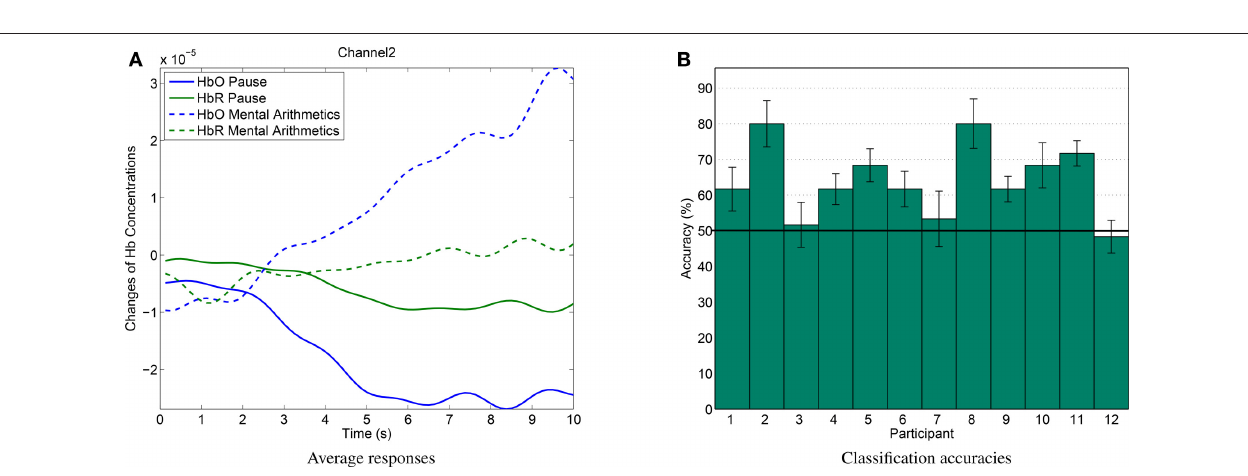
Frontiers in Human Neuroscience |